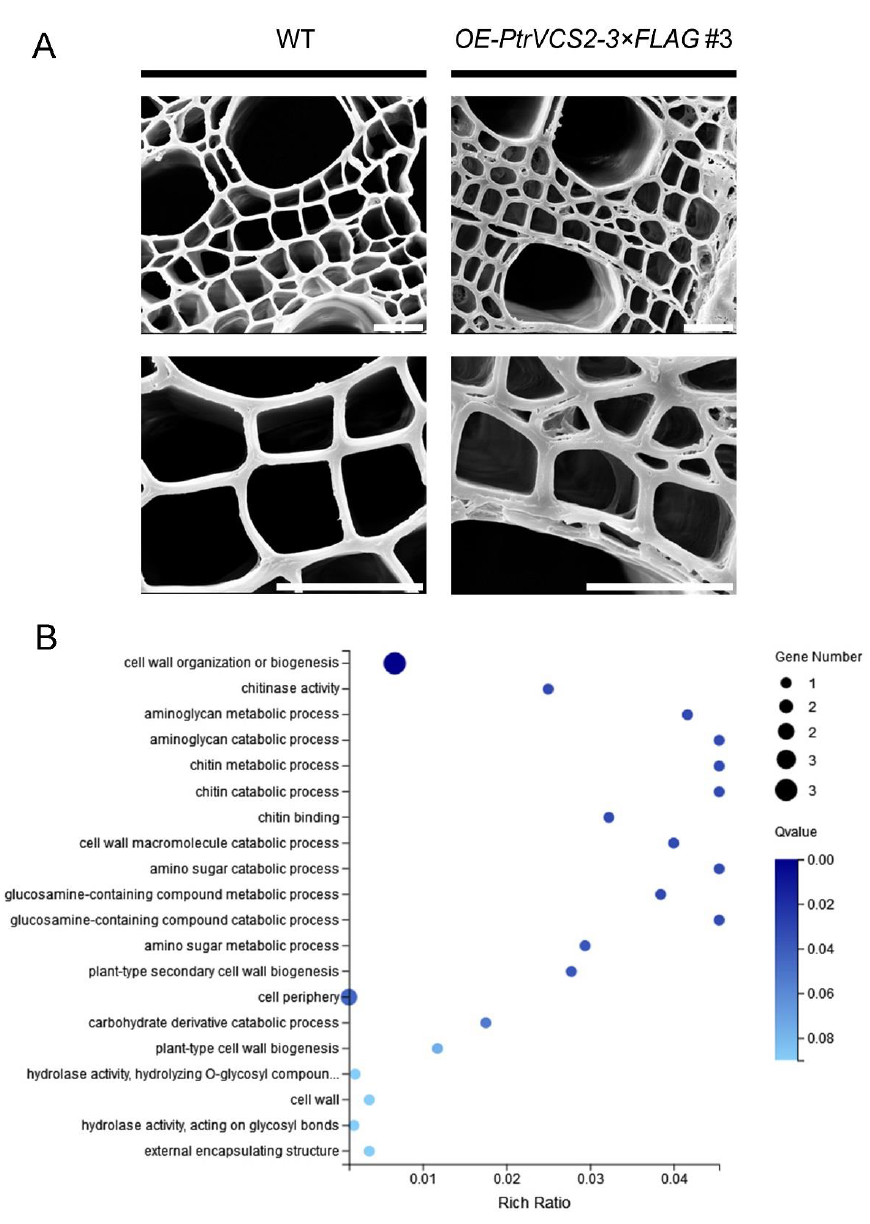
Figure 4. PtrVCS2 regulates the cell wall biosynthesis-related genes. ( A ) Wild-type (WT) and OE- PtrVCS2 transgenic plants were imaged by SEM with the 12th internode imaged at × 1000 (upper panels) and × 3000 (lower panels) magnification. Bars = 20 µ m. ( B ) Gene ontology categories related to cell wall